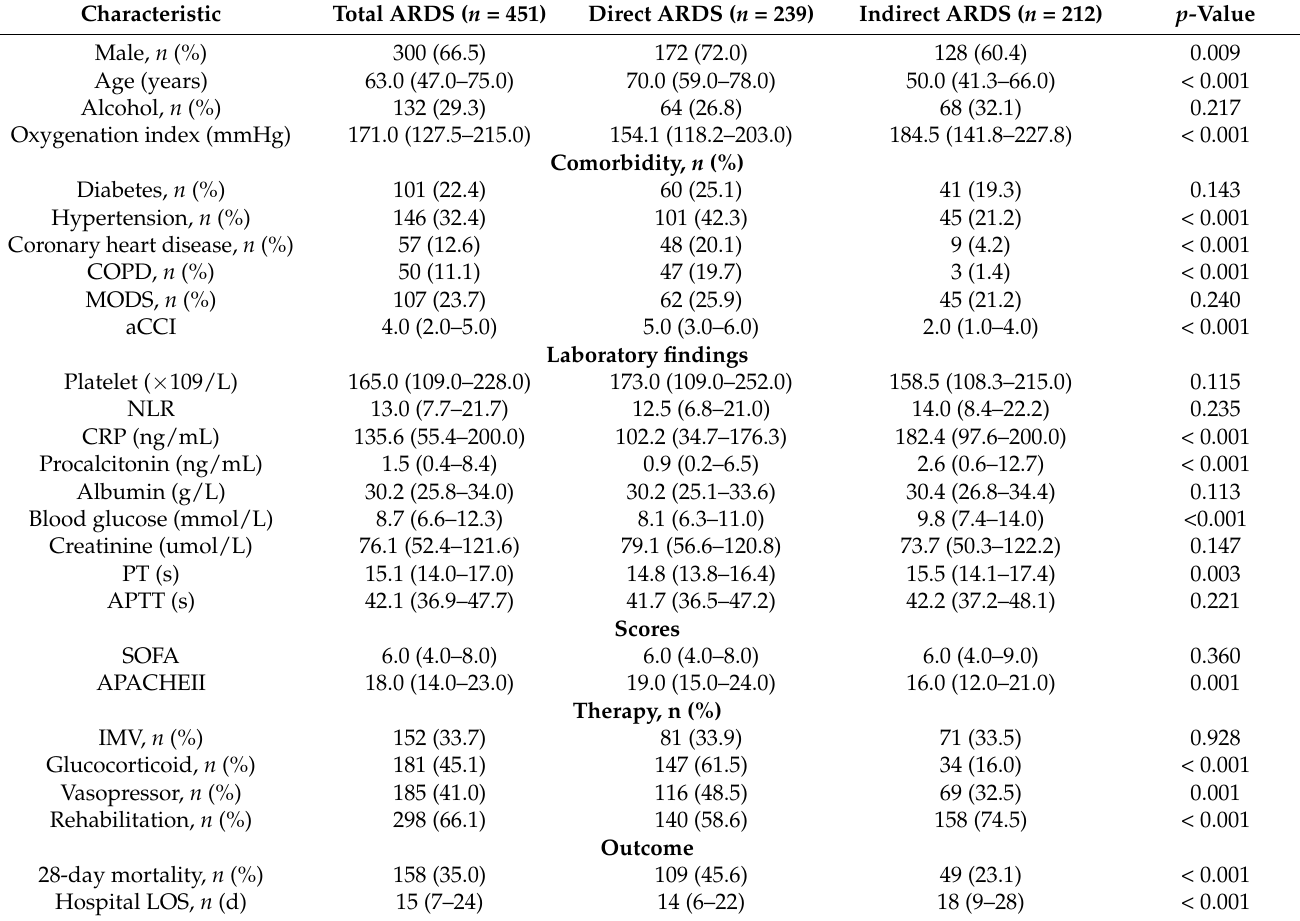
Table 1. Baseline characteristics of direct and indirect